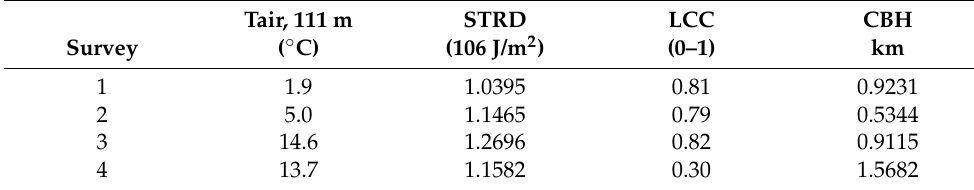
Table 2. ERA5 atmospheric parameters from CDS interpolated to the survey location and time. STRD (surface thermal radiation downward) is measured at the Earth’s surface and includes clouds; LCC (low cloud cover); CBH (cloud base height). Tair, 111 m STRD LCC CBH Survey ( ◦ C) (106 J/m 2 ) (0–1) km